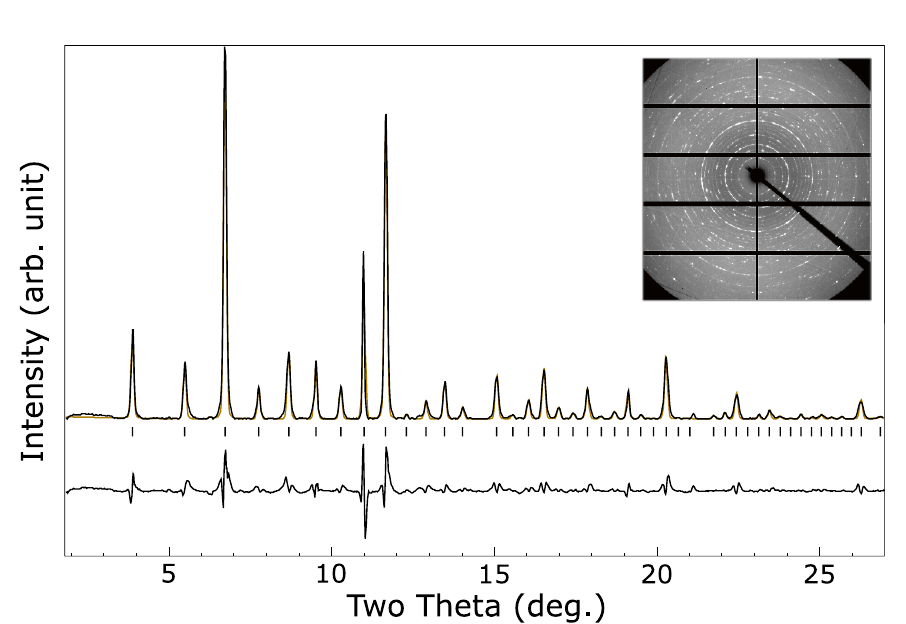
Figure 7. Integrated diffraction pattern of the lithium–palladium–hydrogen intermetallic at ambient ¯ 43 m temperature and 9.74 GPa (black), with LeBail fit to I phase ( a = 8.856 Å) (orange) and residual on same scale (lower black line). Allowed peak positions are indicated by ticks. Inset: Unintegrated diffraction